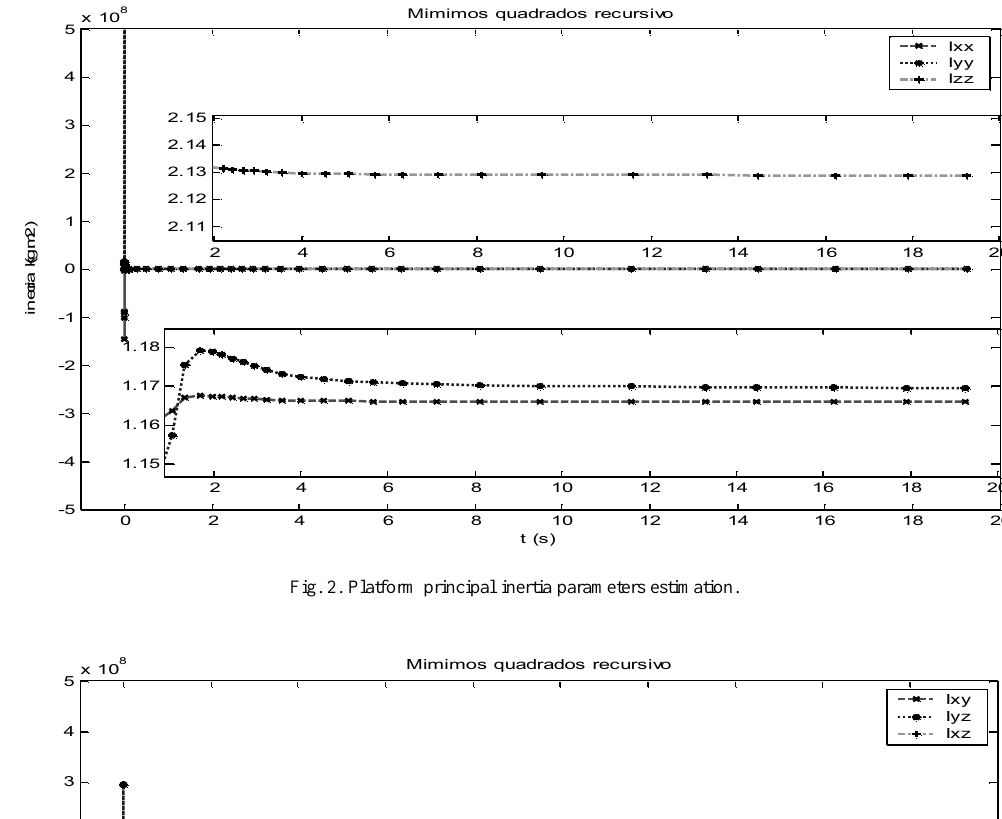
Fig. 2. Platform principal inertia parameters estimation.